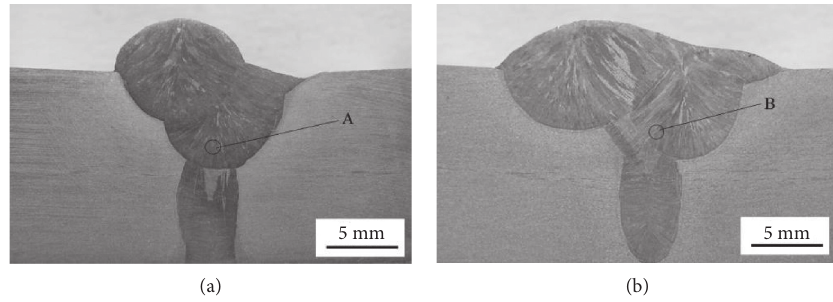
Figure 4: Macroprofile of the welded joints. (a) 98%Ar+ 2%N